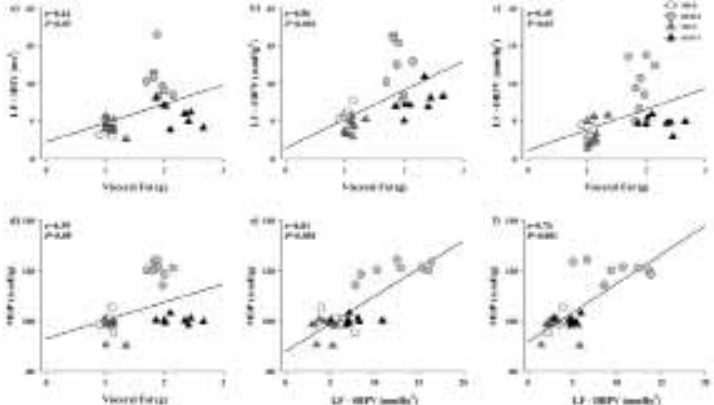
Figure 4. Correlation coefficient between (a) visceral fat and LF component of heart rate variability (HRV), (b) visceral fat and LF component of systolic blood pressure variability (SBPV), (c) visceral fat and LF component of diastolic blood pressure variability (DBPV), (d) visceral fat and mean blood pressure (MBP), (e) LF component of SBPV and MBP and (f) LF component of DBPV and MBP of non-anesthetized Wistar rats submitted to normal diet plus sedentary activity (ND-S, n=8), high-fat diet plus sedentary activity (HFD-S, n=8), normal diet plus exercise training activity (ND-T, n=8) and high-fat diet plus exercise training activity (HFD-T, n=8) treatment during 9 weeks. (Statistical differences were determined by Pearson correlation